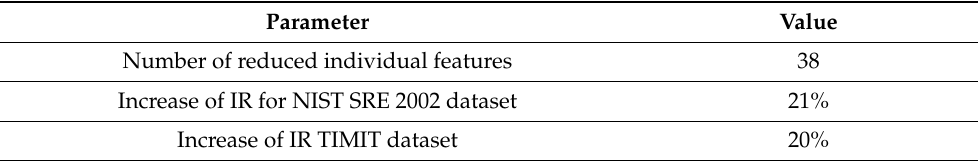
Table 4. Influence of genetic feature selection on the ASR System.